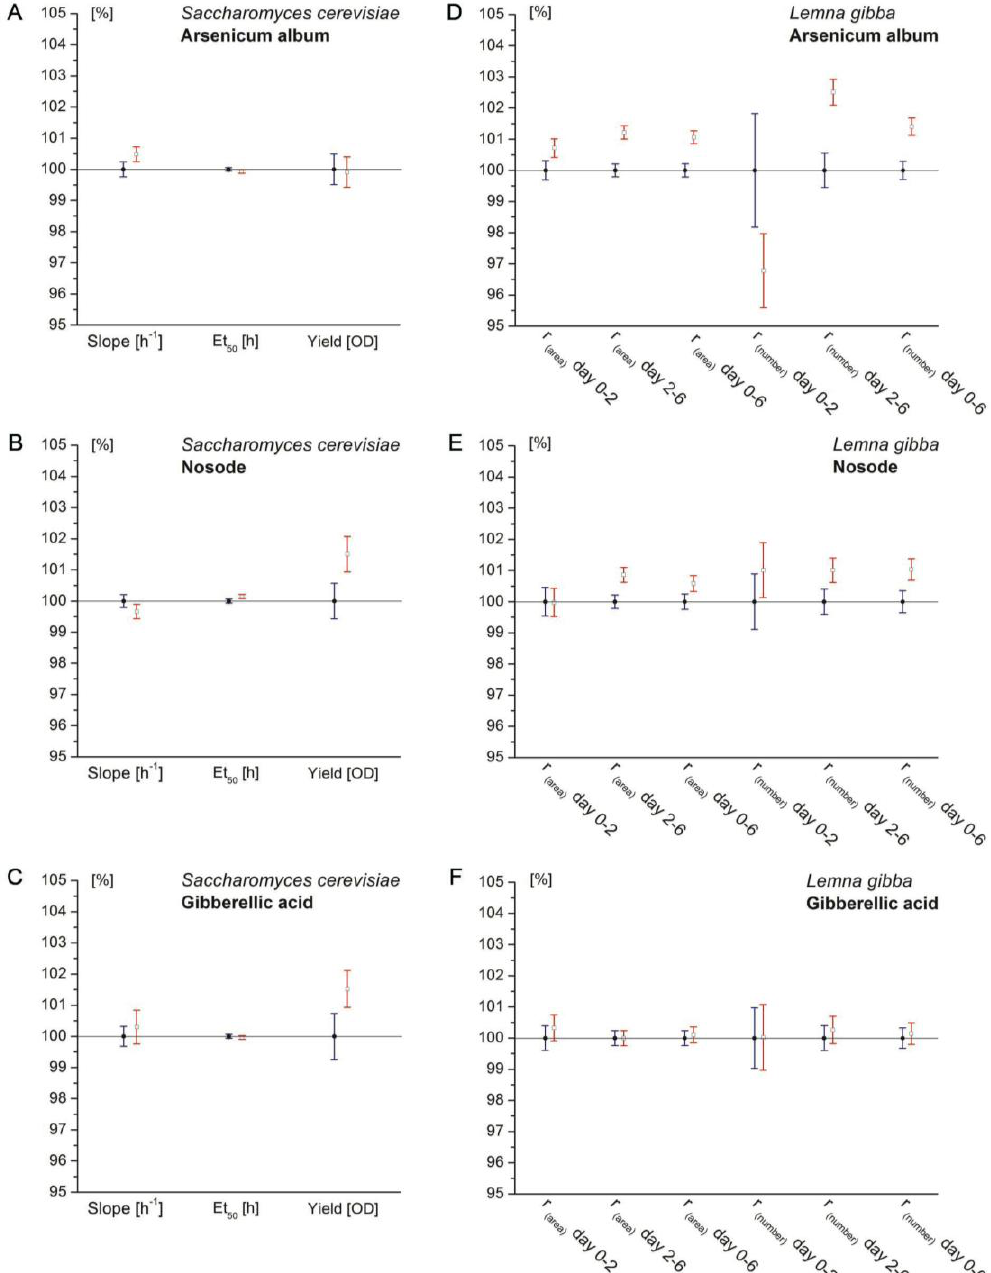
FIGURE 4. Growth kinetics of S. cerevisiae (slope, Et , and yield; A–C) (%) and L. gibba L. 50 (r and r for days 0–2, 2–6, and 0–6; D–F) (%) (mean ± standard error; empty squares: (area) (number) potencies, black dots: controls) treated with different homeopathic preparations: (A,D) Arsenicum album; (B,E) duckweed nosode; (C,F) gibberellic acid. For yeast, data of the five potency levels investigated (17x, 18x, 24x, 28x, 30x) were pooled and compared to the pooled data of the five control samples set to 100% (two samples unsuccussed water, three samples succussed water). For duckweed, data of the nine potency levels investigated (17x, 18x, 21x–24x, 28x, 30x, 33x) were pooled and compared to the pooled data of the nine control samples set to 100% (four samples unsuccussed water, five samples succussed water). All three experimental series (A/D, B/E, C/F) comprised five independently performed experiments,